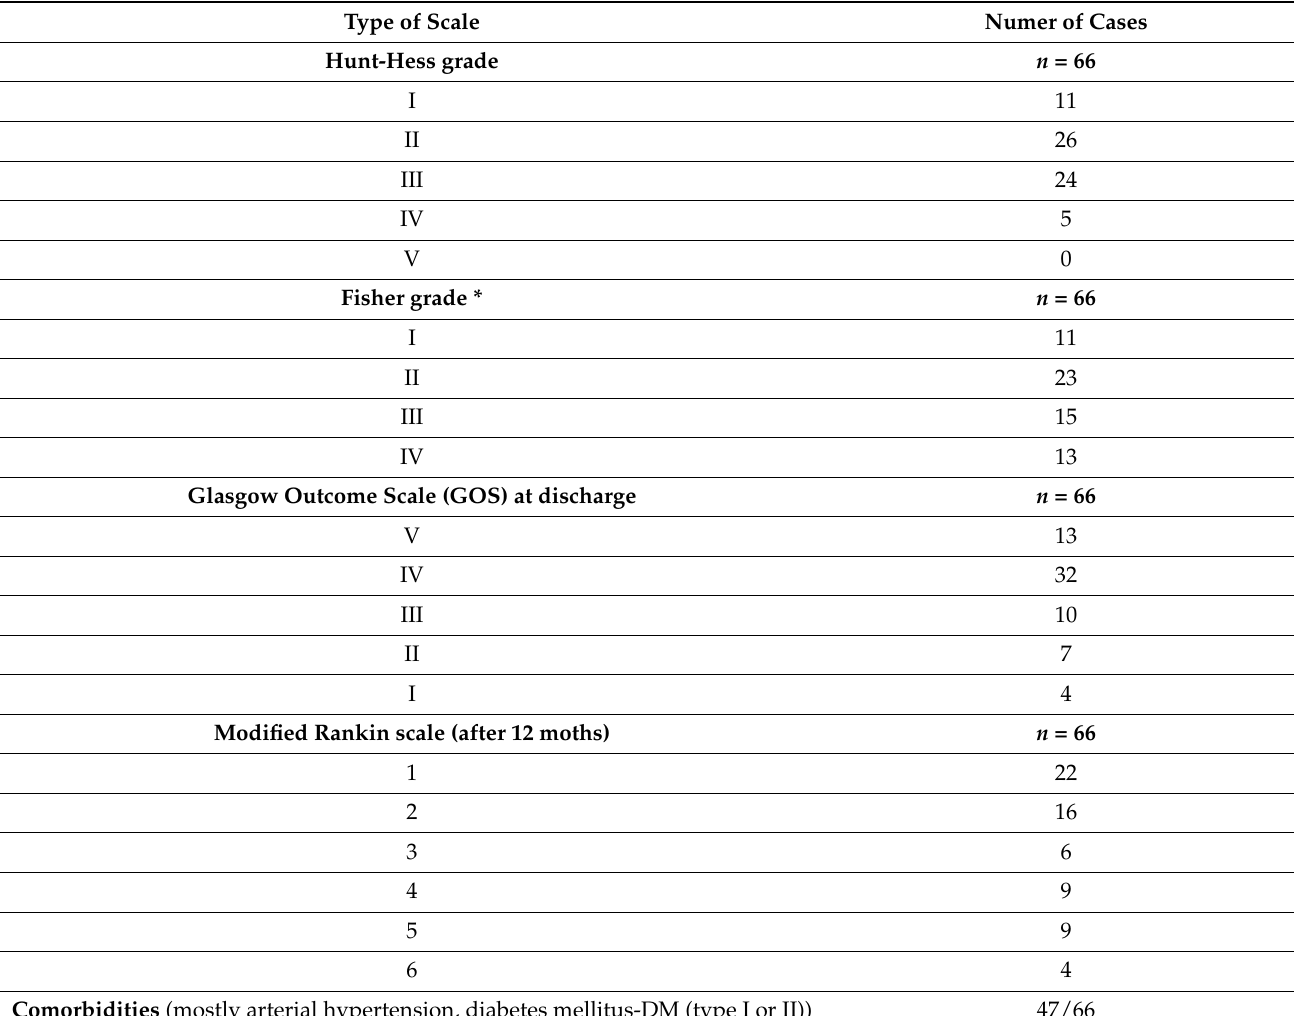
Table 3. Assessment of 66 patients with ruptured aneurysms. Type of Scale Numer of